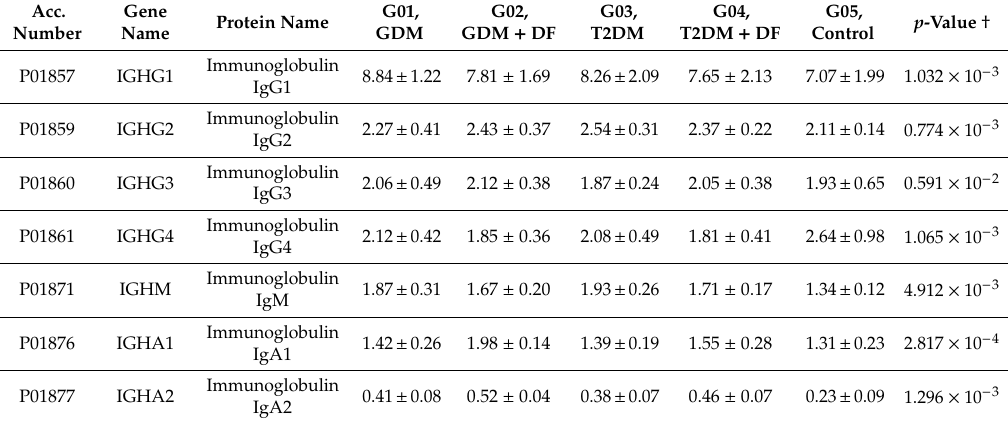
Table 4. Concentrations of the detected and measured immunoglobulins di ff erentiated by subclasses. The most prominent signs for groups with associated diabetic fetopathy are defined by significant alternation in IgA2 and IgG4 concentrations. All concentrations are defined in mg / mL units.